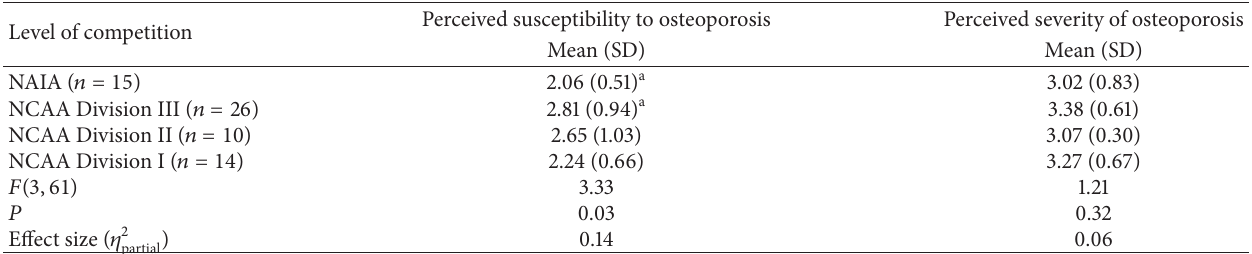
Table 3: Perceived susceptibility to and perceived severity of osteoporosis by level of competition and analysis of variance results. Level of